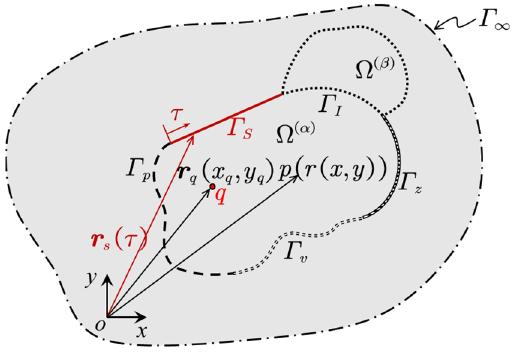
Figure 8. A complete vibro-acoustic system. α Ω Take sub-domain ( ) as an example, to enforce the boundary condition, a weighted residual formulation is used.